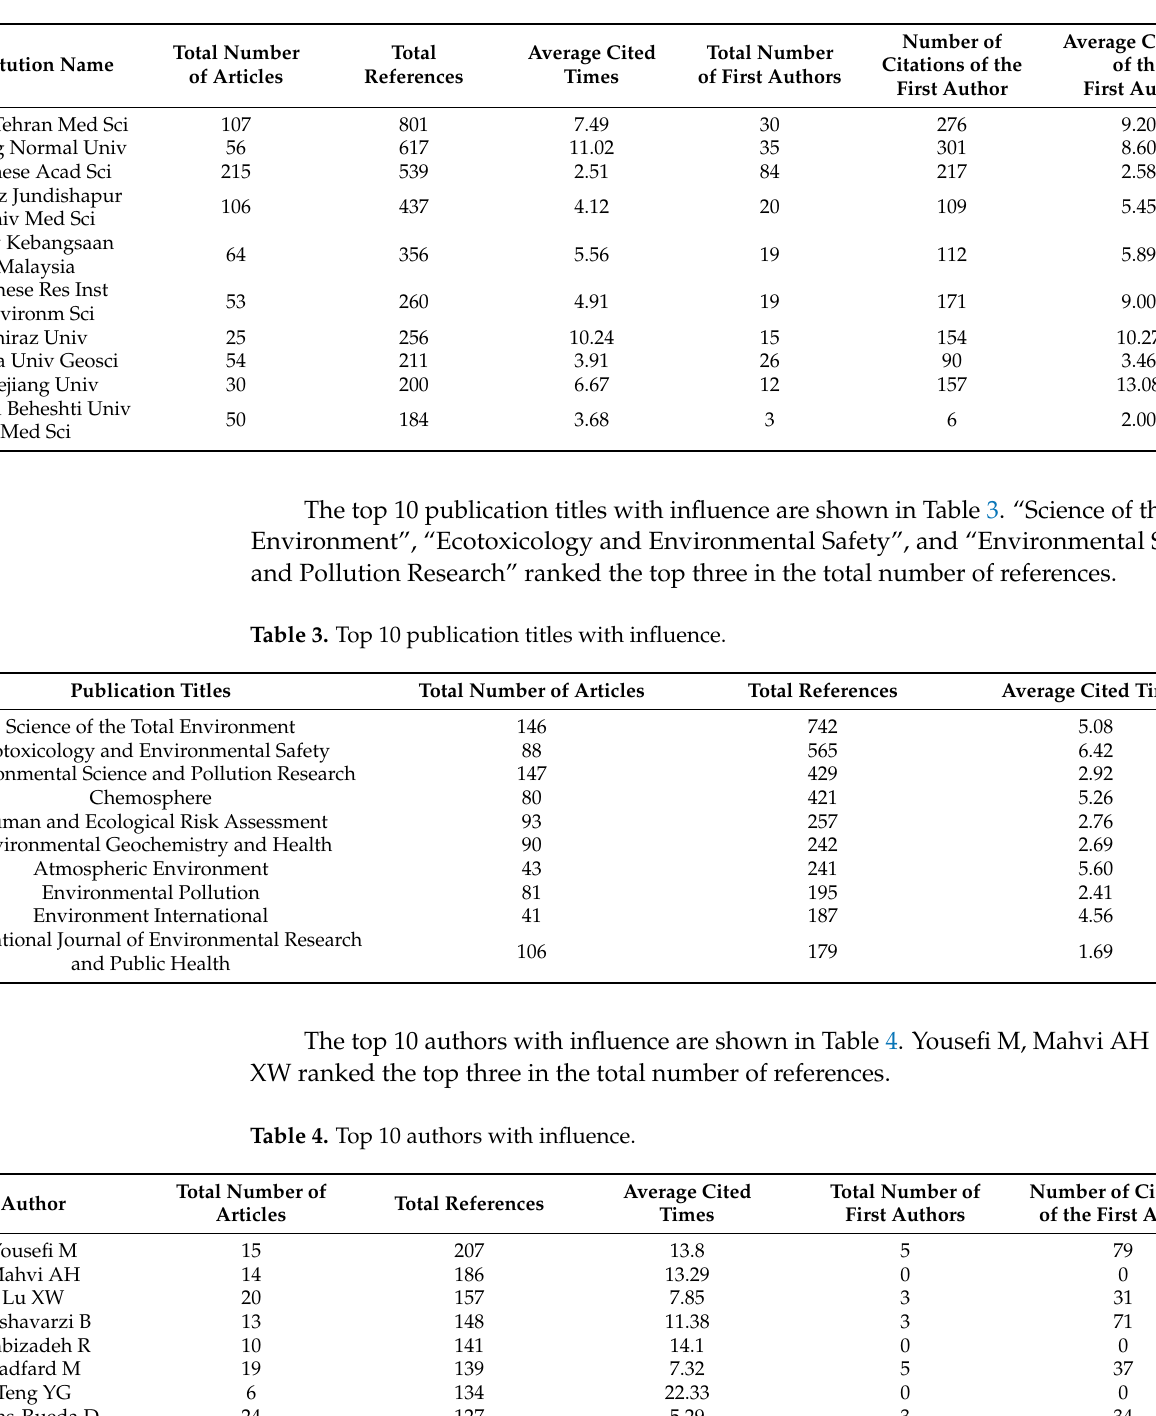
Table 2. Top 10 institutions with influence.